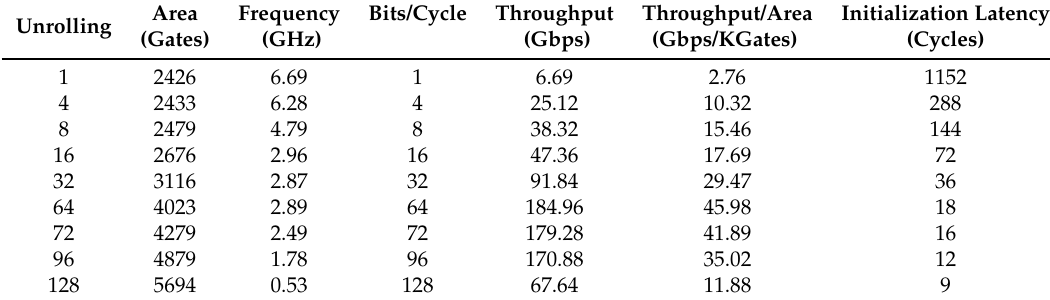
Table 10. Trivium synthesis results (65 nm).